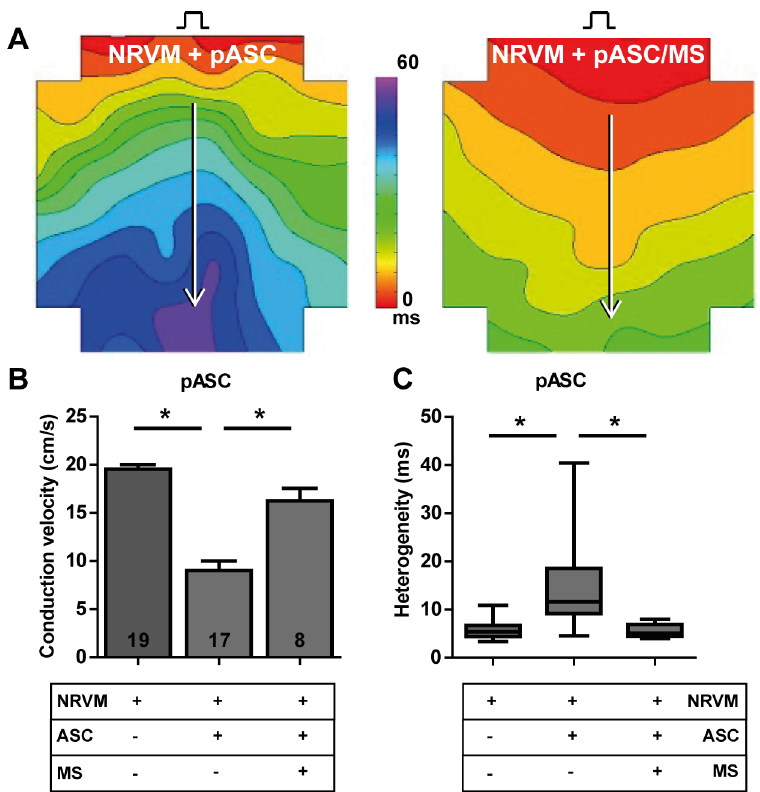
Fig 5. Influence of recombinant human collagen-based microspheres on conduction slowing mediated by a paracrinemechanism. A: Activation map of a monolayerof NRVM co-culturedwith pASC (left), and an activationmap of a monolayerof NRVM cultured with pASC loadedmicrospheres (right). Conduction velocity is determined along the white arrows perpendicular to isochronal(black) lines. Lower panels:the effects on B: conductionvelocity and C: conductionheterogeneity. * indicatesp < 0.001 compared to the NRVM + pASC. Number of replicates per experimental conditionis indicatedin the bar-graphs. Abbreviations; MS: microspheres, NRVM: neonatalrat ventricular myocytes, and pASC: porcine adipose tissue-derived stromal cells.